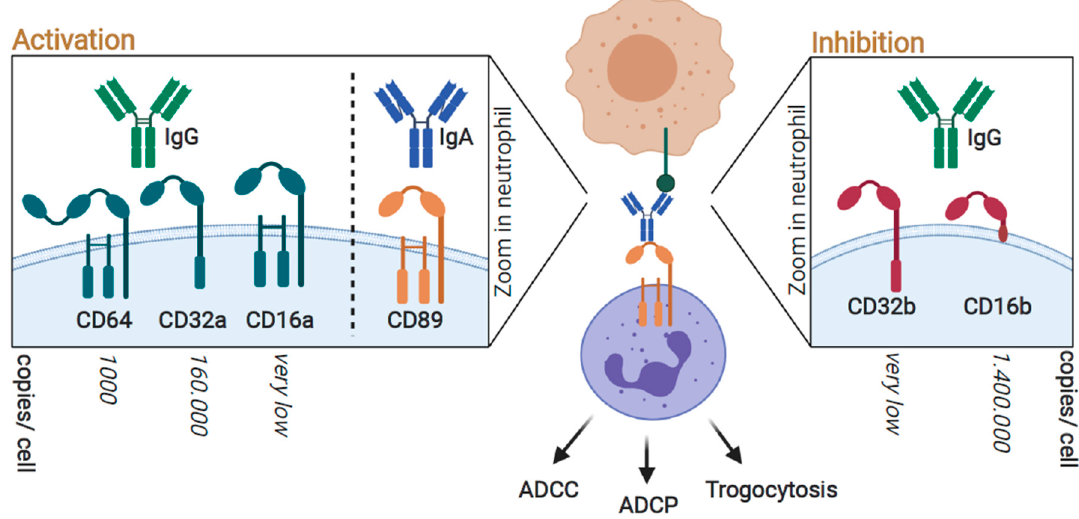
Figure 2. Antibody-mediated FcR activation of neutrophils. Neutrophils express various FcRs that are either activating or inhibitory, thereby respectively stimulating or repressing neutrophil-mediated antibody-dependent cellular phagocytosis (ADCP), antibody-dependent cellular cytotoxicity (ADCC), and trogocytosis. Among the activation receptors are the immunoglobulin G (IgG)-binding FcRs; CD64, CD32a and CD16a. In addition, neutrophils express the immunoglobulin A (IgA)-binding FcR CD89. Inhibitory IgG-binding FcRs that are expressed by neutrophils comprise CD32b and CD16b.